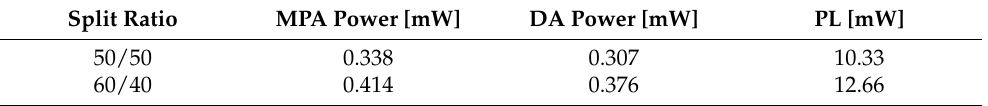
Table 14. Power Loss (PL) and Efficiency in the MPA and DA conduits as a function of split ratio. Split Ratio